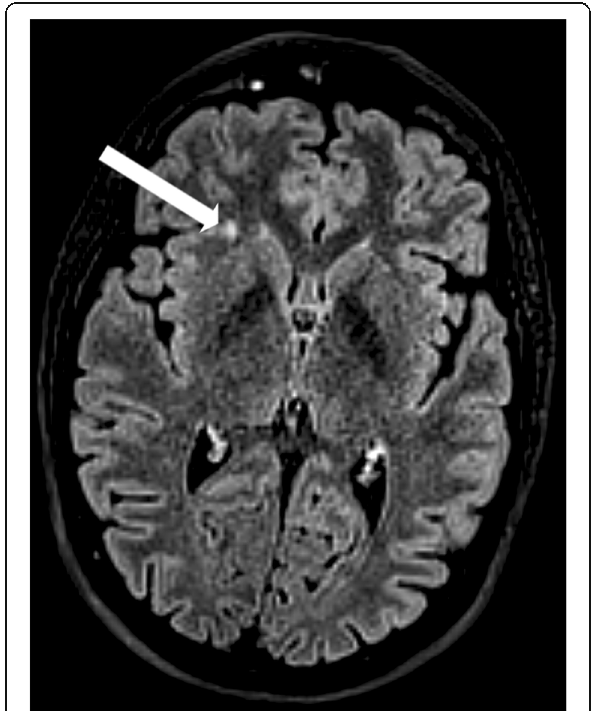
Fig. 1 White matter lesion of a migraine patients. The arrow shows a deep brain white matter lesion in the right frontal lobe seen on the axial fluid-attenuated inversion recovery image. The image is in radiological